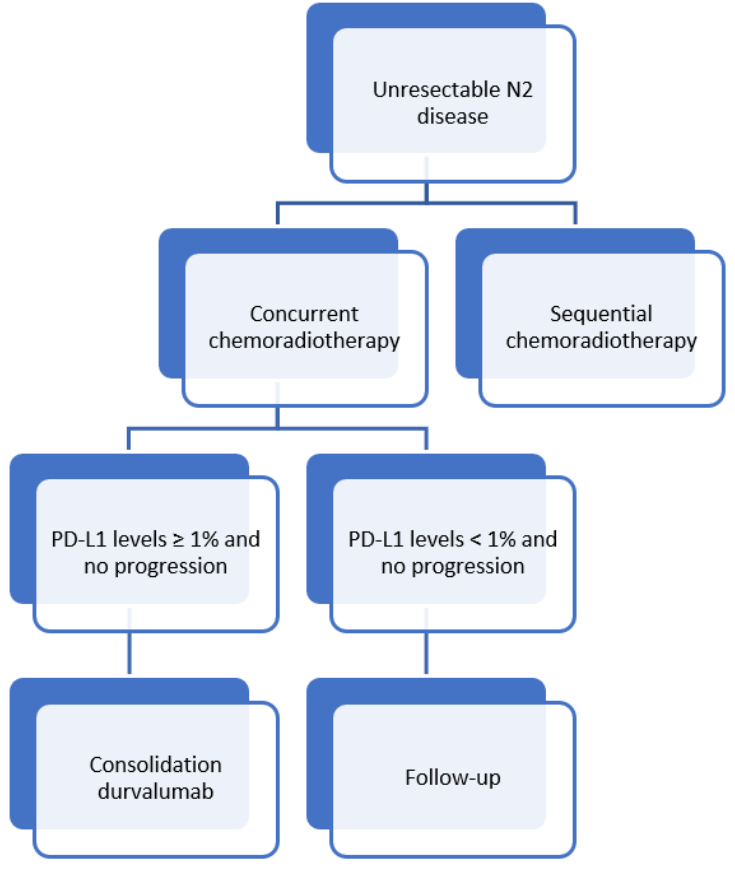
Figure 3. Current treatment algorithm at Antwerp University Hospital for unresectable N2 disease.